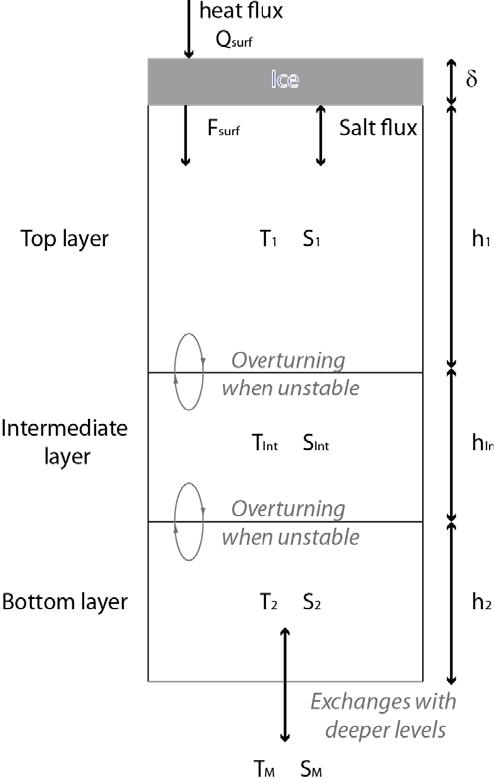
Fig. 6. Schematic representation of the three-level model displaying Figure 6. Schematic representation of the three-level model displaying the dominant processes the dominant processes included and the state included and the state variables.